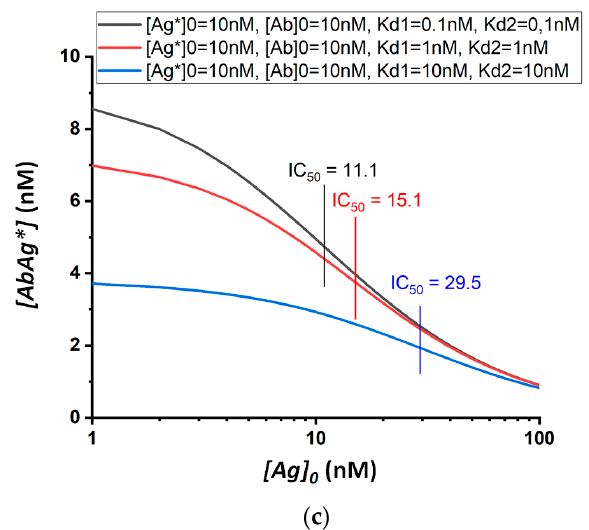
Figure 3. Theoretical calibration dependences of equilibrium competitive immunoassay for three model structurally similar compounds (I, II, and III; black, red, and blue curves in each sub-figure, respectively) and three assay formats differing in the used concentrations of analytical reactants: (a) [Ab] 0 = 1 nM, [Ag*] 0 = 1 nM; (b) [Ab] 0 = 10 nM, [Ag*] 0 = 1 nM; (c) [Ab] 0 = 10 nM, [Ag*] 0 = 10 nM.